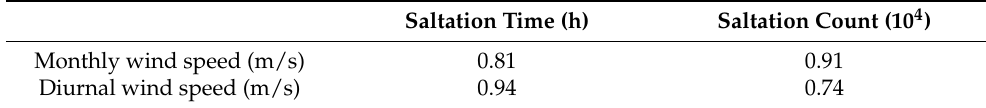
Table 2. Correlation coefficients between wind speeds and saltation